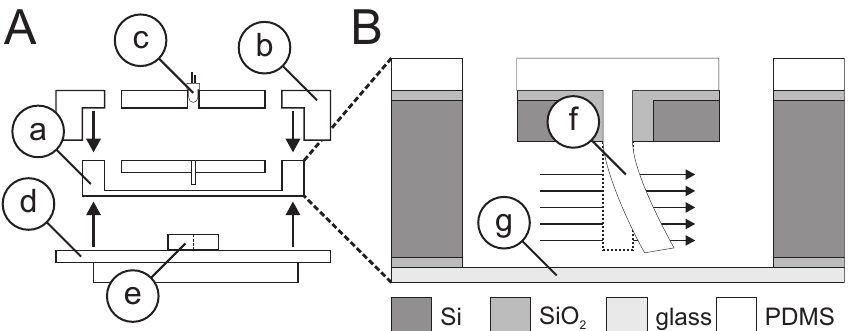
Figure 2. Assembly of the micro-machined CN. ( A ) Assembly of the sensory device featuring the Si-chip (a), housing (b), LED (c), electronics PCB (d) with the optical detector (e); ( B ) magnified Si-chip featuring a PDMS lamella (f) and a glass plate (g). Note that the illustration is not to scale. Modified from